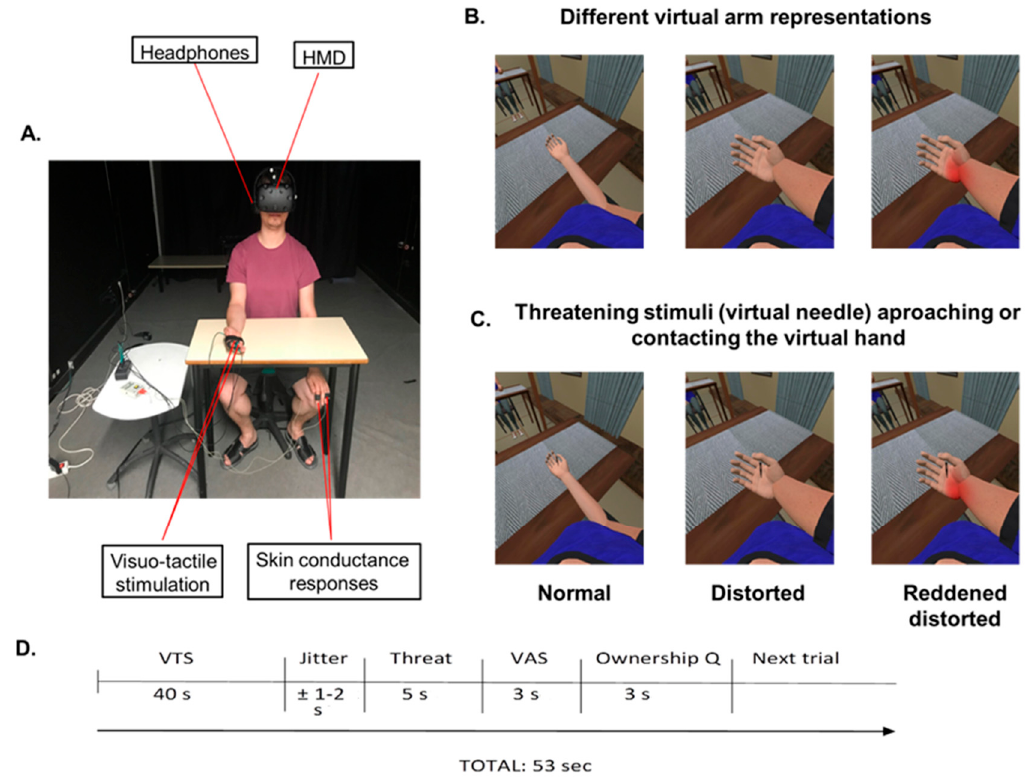
Figure 1. Experimental set-up and virtual arm and threatening stimulus conditions. ( A ) Participants wore a head-mounted display (HMD) that immersed them in a virtual environment. This allowed them to feel embodied in a virtual body, which they saw from a first-person perspective and which was co-located with their real body. Using headphones, participants heard the task instruction, “Pay attention to the right arm placed on the table, please,” before each visuo-tactile stimulus phase, which lasted 45 s. During the visuo-tactile stimulation, which was used to induce ownership over the virtual arm, virtual balls tapped the virtual fingers while participants felt, simultaneously, a tactile stimulation (vibration) on their real fingers. To record skin conductance responses after each threatening stimulus, two electrodes were attached to the index and ring fingers of the participants’ left hands. ( B ) Di ff erent virtual arm representations (virtual arm factor): normal representation, distorted representation (telescoped virtual arm), and reddened-distorted representation of the virtual arm. The distorted representation of the virtual forearm was shrinking within the virtual arm, as occurs with the telescoping e ff ect in amputee patients. However, from a participant’s first-person perspective it seems bigger than the normal representation. ( C ) Threatening stimulus (virtual needle) in all three levels of the virtual arm factor. ( D ) Timeline of one experimental trial. Each experimental trial lasted around 53 s and was divided into four parts: First, participants were immersed in an immersive virtual reality (VR) environment in which the virtual arm could either be distorted, reddened and distorted, or in a normal position. To induce ownership over the virtual arm, they received 45 s of synchronous visuo-tactile stimulation. Second, after a jitter of 1–2 s, the threatening event appeared (a virtual needle) for 5 s. Immediately after the threatening event, the VAS appeared on the screen of the HMD. Finally, after the VAS was taken, a question related to ownership over the virtual arm appeared. VTS, visuo-tactile stimulation VAS, visual analogue scale; Ownership Q, ownership questionnaire.